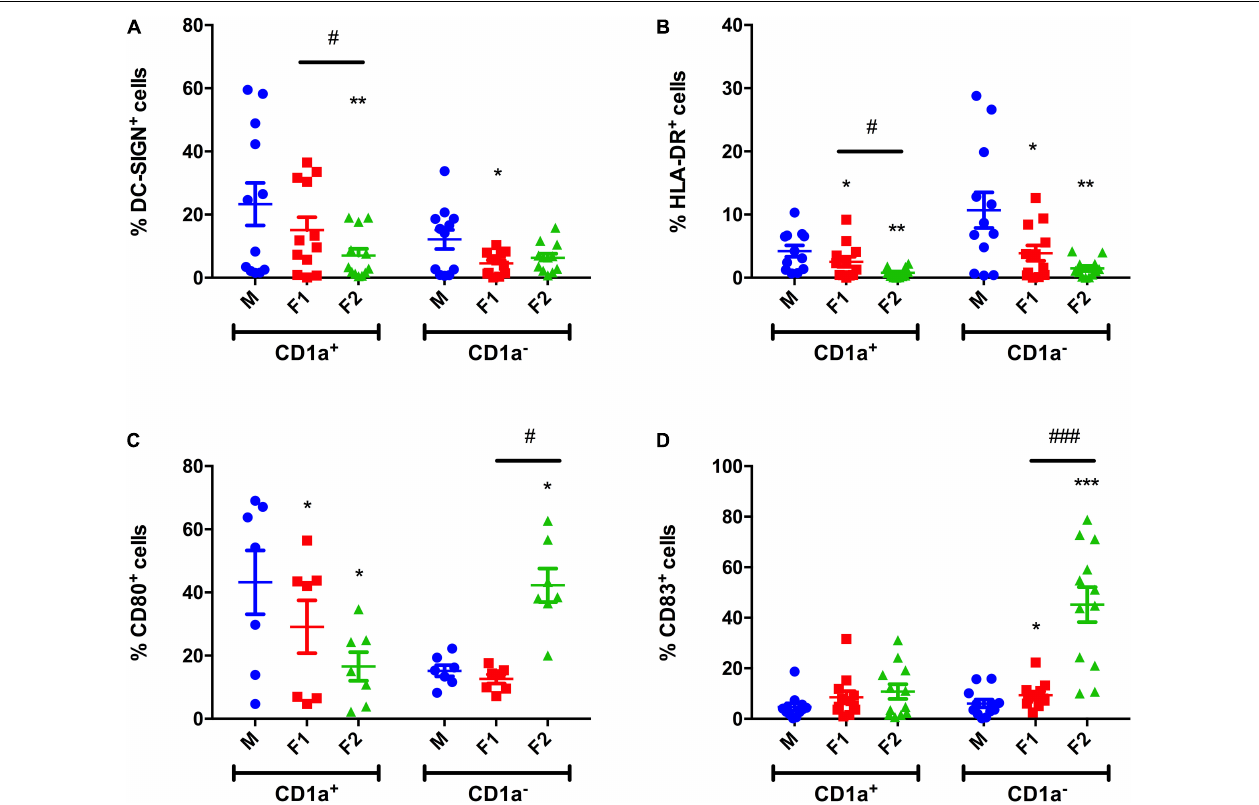
FIGURE 3 | Paracoccidioides brasiliensis cell wall fractions modulate CD1a subsets phenotype. Frequency of DC-SIGN + (A) , HLA-DR + (B) , CD80 + (C) , and CD83 + (D) cell populations after differentiation upon F1 or F2 stimulation. Non-stimulated cells were used as a control (M). Each data point represents one donor. Wilcoxon matched pairs T test. ∗ p < 0.05, ∗∗ p < 0.01, and ∗∗∗ p < 0.001 in comparison to control group. # p < 0.05 and ### p < 0.001 between groups treated with cell wall